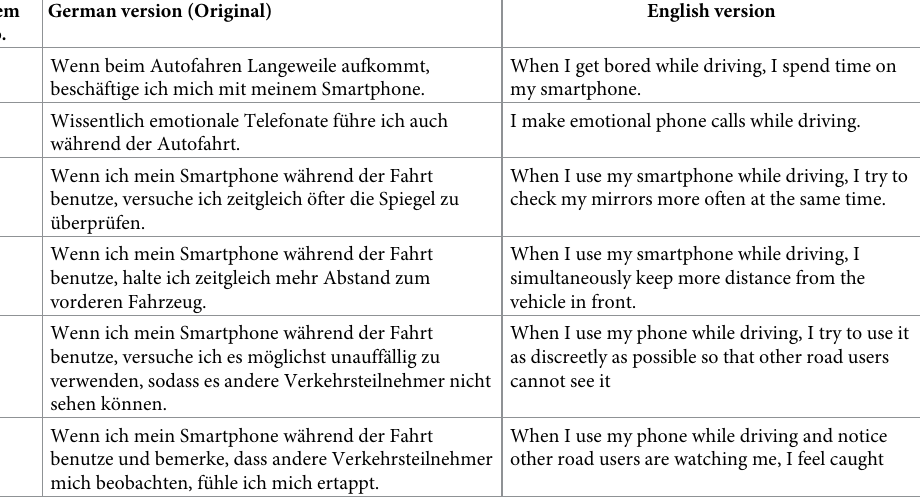
Table 2. Overview of the six items used to measure smartphone use while driving (SUWD). Item